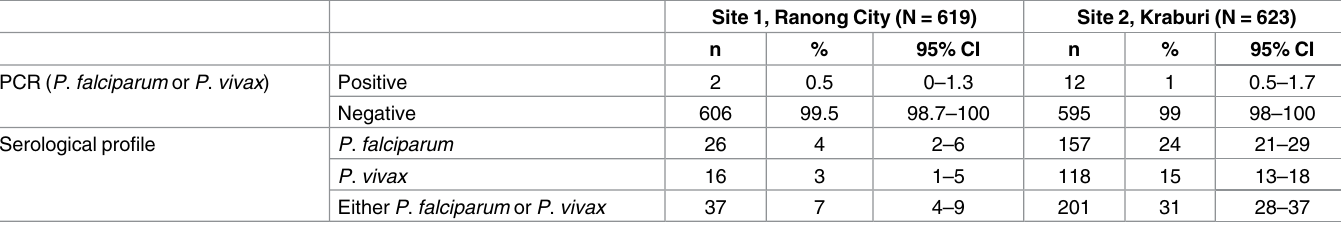
Table 6. RDS-weighted estimates comparing biological results by site.